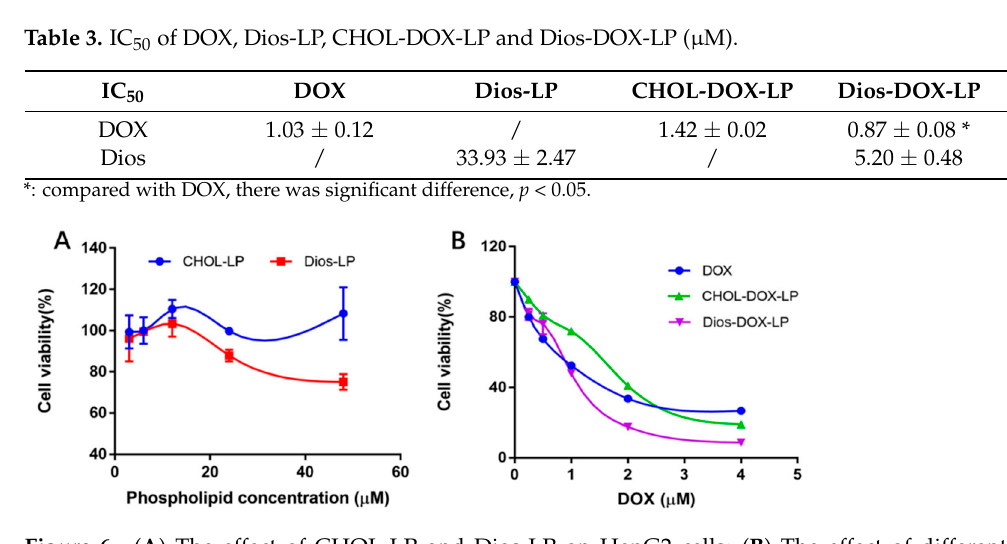
Figure 6. ( A ) The effect of CHOL-LP and Dios-LP on HepG2 cells; ( B ) The effect of different concentrations of DOX, CHOL-DOX-LP, and Dios-DOX-LP on HepG2 cells.